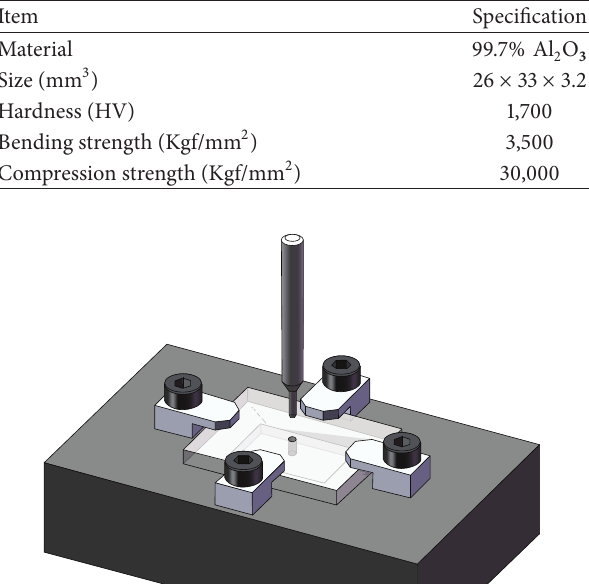
Table 3: Ceramic specifications.